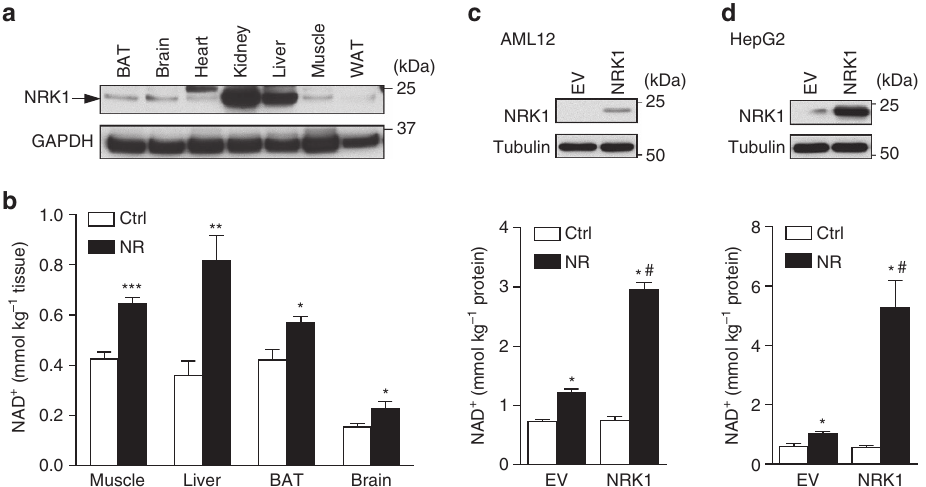
Figure 3 | NRK1 and NR metabolism in hepatic cells. ( a ) Protein levels of NRK1 in mouse tissues. ( b ) 7–9 weeks old WTmale mice were IP injected with 500mgkg (cid:2) 1 of NR or vehicle and tissues were collected after 1h. NAD þ measurement in selected tissues, n ¼ 5 per group. ( c , d ) AML12 ( c ) and HepG2 ( d ) cells were transfected with NRK1-overexpressing vector. NRK1 protein levels and NAD þ measurement after 6h 0.5mM NR treatment. Results shown are mean ± s.e.m., * P o 0.05, ** P o 0.01, *** P o 0.001 versus ctrl; # P o 0.05 versus EV by two-sided unpaired T -test or (in c and d ) one-way ANOVA followed by Bonferroni’s post-hoc test ( n ¼